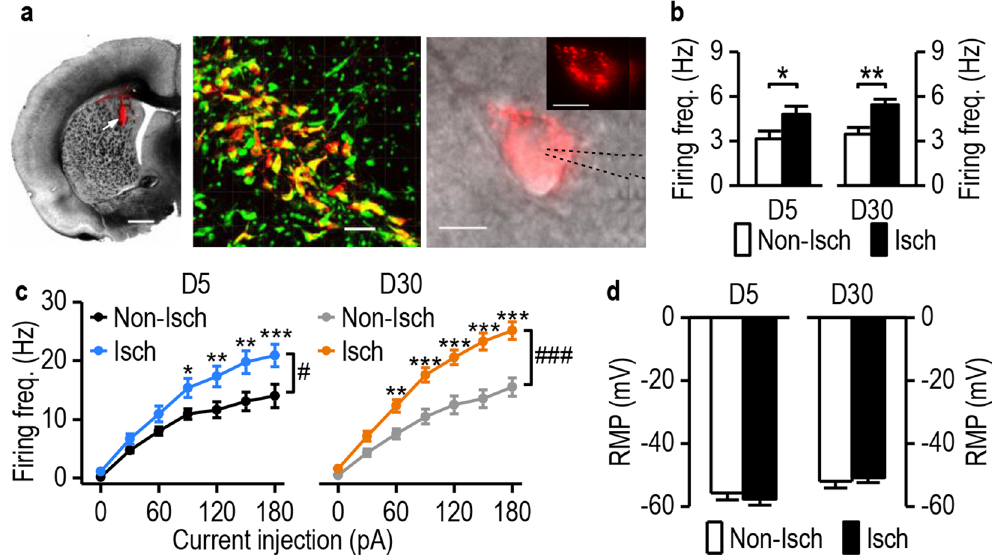
Figure 6. Stroke increases spike firing frequency of DMS-projecting SNc neurons in alcohol-drinking rats. ( a ) Retrograde labeling of DMS-projecting SNc neurons. Left, Light microscope image showing the retrograde red beads (arrow) that were injected into the DMS. Middle, confocal image of the SNc showing bead-positive neurons (yellow). Sections were stained with NeuroTrace green. Right, differential interference contrast (DIC) and red- fluorescent image of a recorded DMS-projecting SNc neuron. Scale bars: 1 mm (left), 50 µ m (middle), 10 µ m (right), 10 µ m (right, inset). ( b ) Bar graphs showing increased spontaneous firing frequencies on D5 (left) and D30 (right). * p < 0.05 and ** p < 0.01 by t test. D5: n = 9 neurons from 6 rats (Non-Isch) and 11 neurons from 7 rats (Isch); D30: n = 12 neurons from 7 rats (Non-Isch) and 11 neurons from 9 rats (Isch). ( c ) Stroke increased the excitability of DMS-projecting SNc neurons on D5 (left) and D30 (right). # p < 0.05 and ### p < 0.001, two-way RM ANOVA, * p < 0.05, ** p < 0.01, and *** p < 0.001 vs. Non-Isch, with the same intensity of current injection, post- hoc SNK test. D5: n = 11 neurons from 6 rats (Non-Isch) and 9 neurons from 8 rats (Isch); D30: n = 13 neurons from 9 rats (Non-Isch) and 14 neurons from 8 rats (Isch). ( d ) Bar graphs showing no difference between the resting membrane potentials (RMP) on the Non-Isch and Isch sides, although an overall difference between D5 (left) and D30 (right) was found. D5: n = 11 neurons from 7 rats (Non-Isch) and 9 neurons from 8 rats (Isch); D30: n = 13 neurons from 9 rats (Non-Isch) and 14 neurons from 8 rats